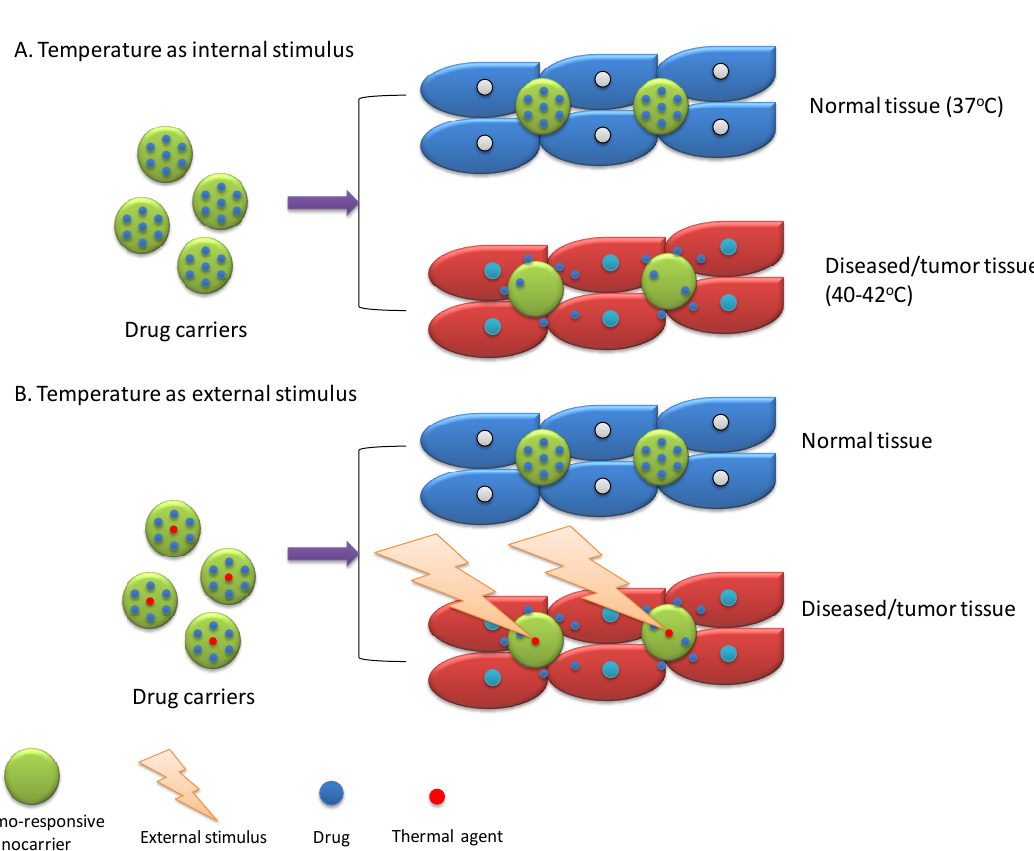
Figure 7. Schematic presentation of drug release activated by temperature responsive nanocarriers through temperature as an internal and external stimulus.